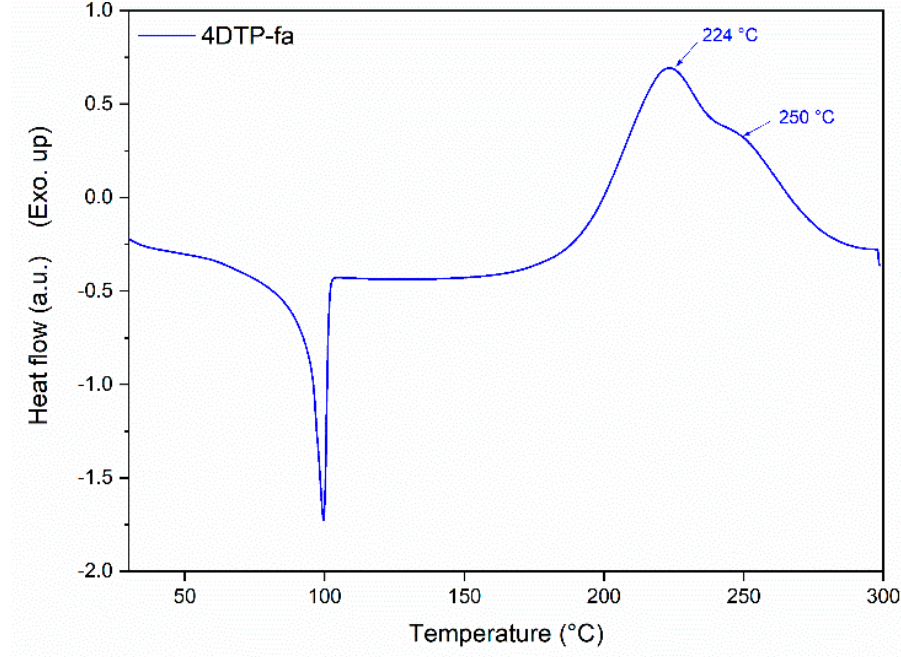
Figure A15. DSC thermogram of 4DTP-fa.